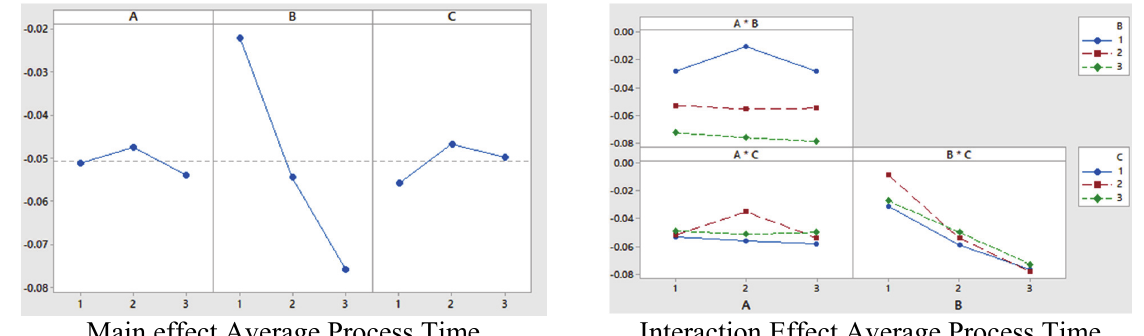
Fig. 12. Effect analysis - Average Process Time